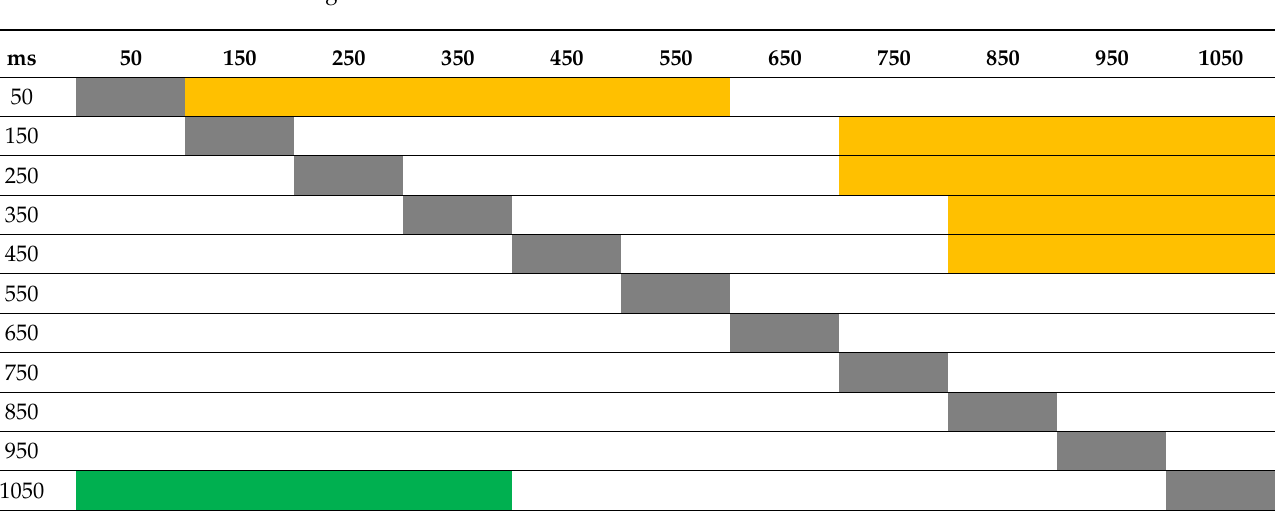
Figure A9. RMSE ( left ) and cross-correlation ( right ) of MDF algorithm for different window sizes. Table A9. Statistical significance between window sizes for MDF algorithm. Green indicates statisti- cally significant difference ( p < 0.05; Bonferroni-corrected) for the RMSE metric, and orange indicates significant difference ( p < 0.05; Bonferroni-corrected) for the cross-correlation metric. Grey indicates diagonal fields.